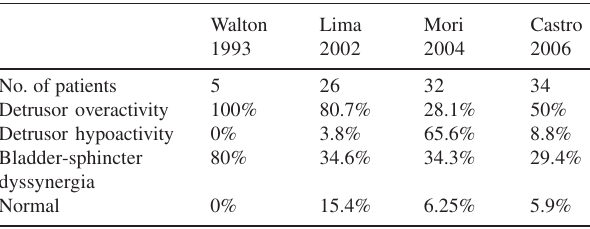
Table 2 - Urodynamic findings in patients with HAM/TSP *